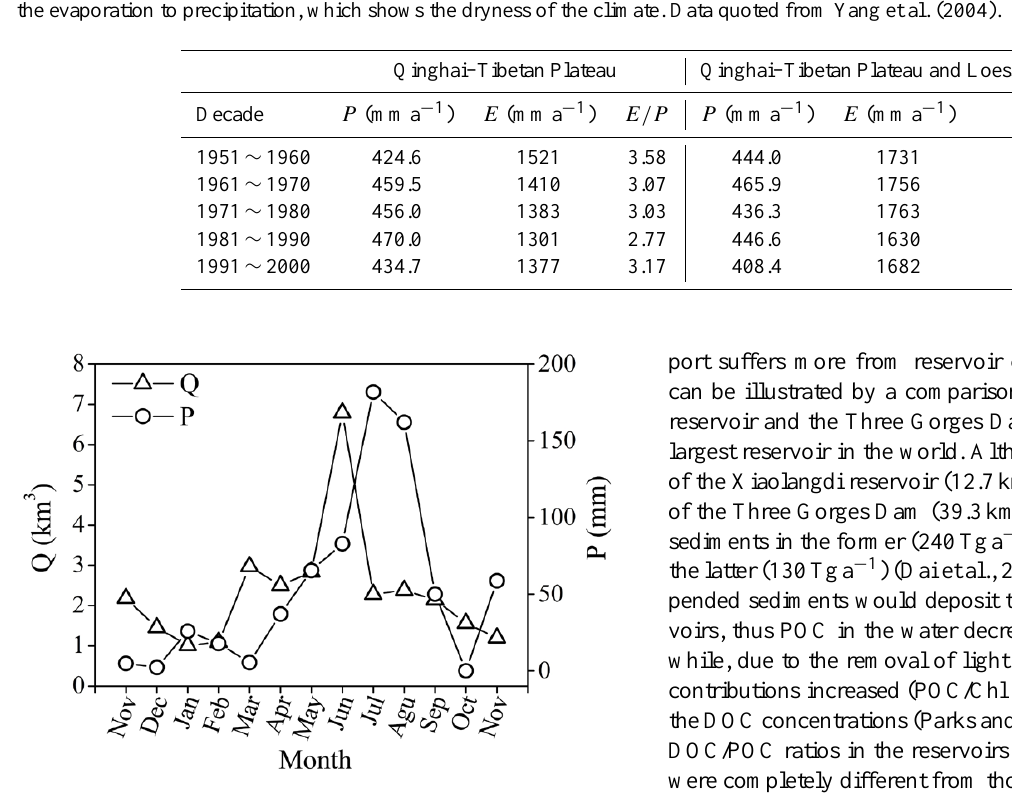
Fig. 6. Monthly precipitation ( P ) and discharge ( Q ) during the 1yr observation (between November 2005 and November 2006) at the Huayuankou station (precipitation data was quoted from http://cdc.cma.gov.cn/home.do and discharge data was quoted from the Yellow River Sediment Bulletin,